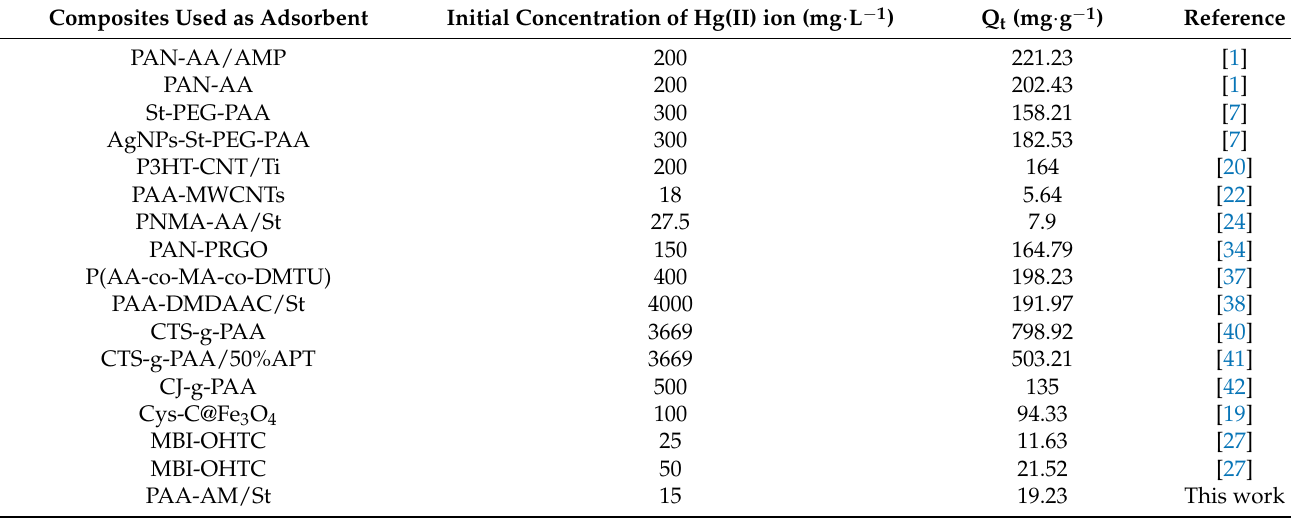
Table 3. Adsorption capacity of various composite materials for Hg(II) ion at different initial concentrations. Composites Used as